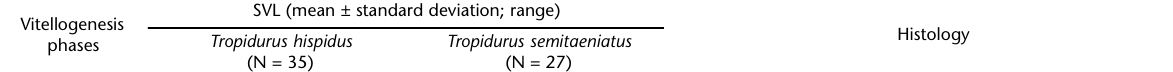
Table I. Folliculogenesis in Tropidurus hispidus and Tropidurus semitaeniatus , indicating snout-vent length (SVL) of the females and sample size for each follicular phase with the basic description of the histological changes. Vitellogenesis